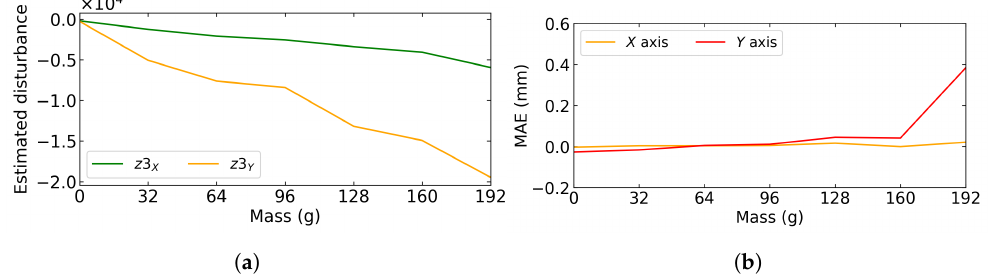
Figure 21. Generalized disturbance estimation and mean steady state error for X and Y axes to different values of radial load aligned with the Y -axis. ( a ) Generalized disturbance estimation ( z 3 ). ( b ) Mean absolute error for X and Y